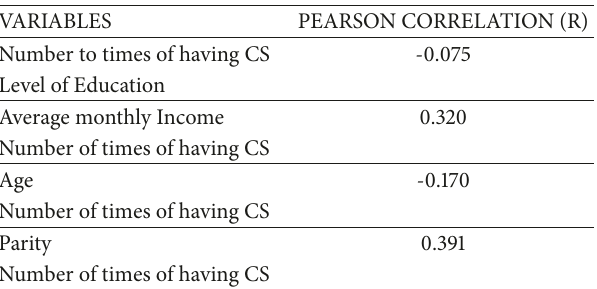
Table 3: Summaries of Pearson (r) correlation